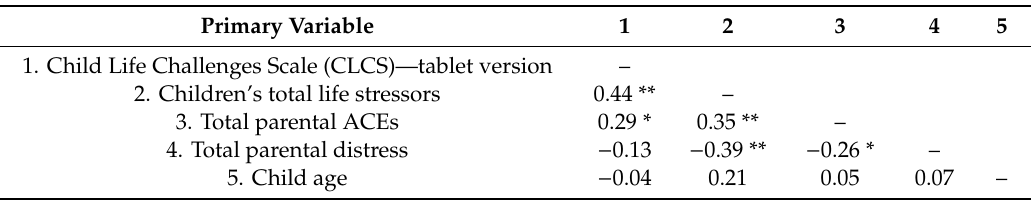
Table 1. Bivariate Correlations for 99 Homeless